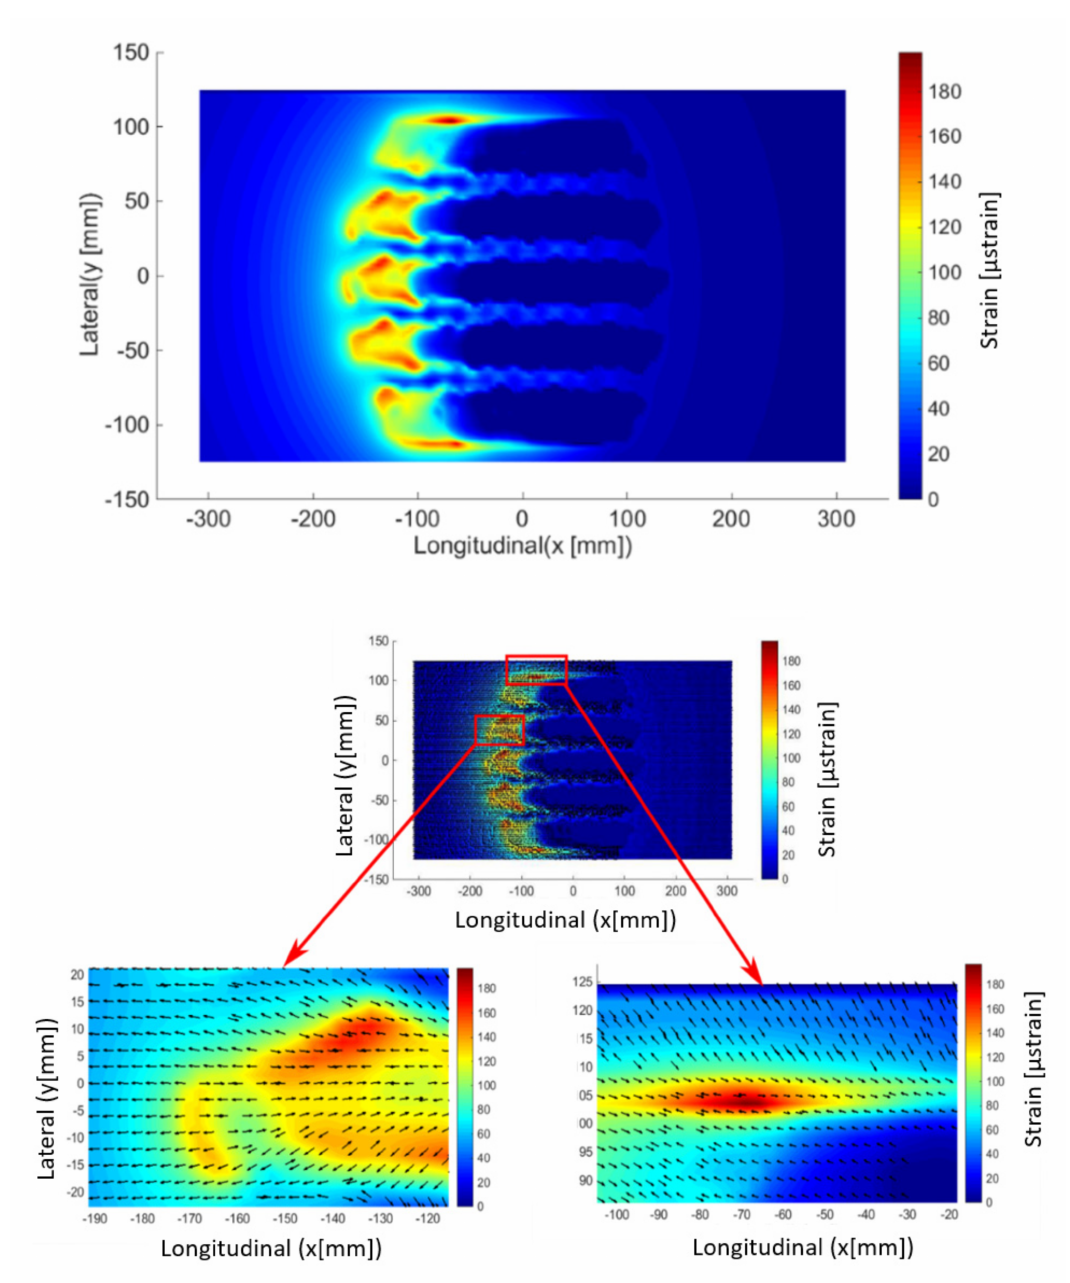
Figure 9. Maximum principal strain (by extension) at the pavement surface ( up ) and corresponding principal direction ( bottom ) for a tractive rolling